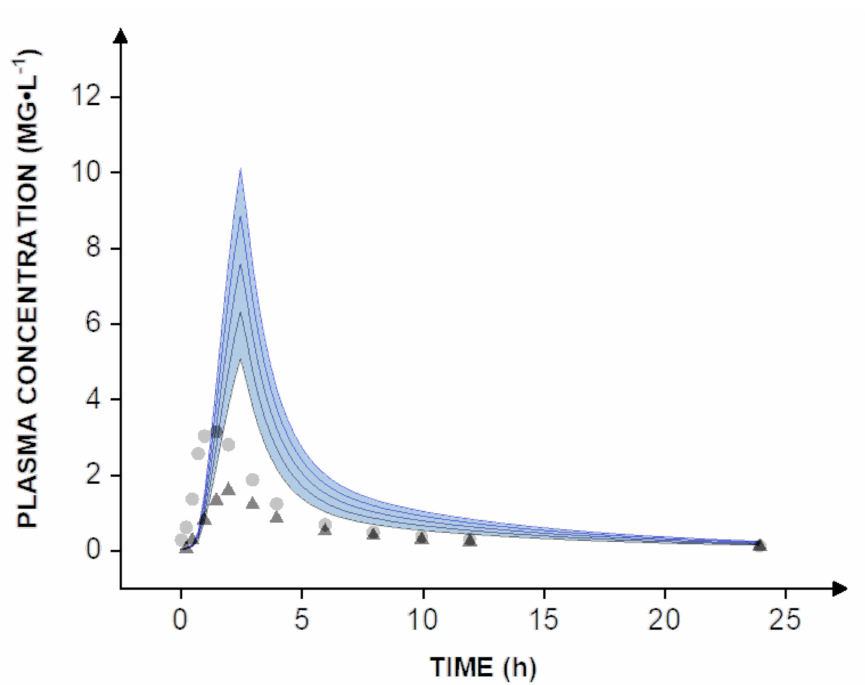
Figure 4. Simulation of human pharmacokinetics following single-dose administration of 40, 50, 60, 70, and 80 mg of valsartan nanoparticles (blue lines) and, for comparison, mean plasma concentrations observed after the administration of a solution (gray circles) and a capsule formulation (dark gray triangles), comprising 80 mg of valsartan to 12 healthy